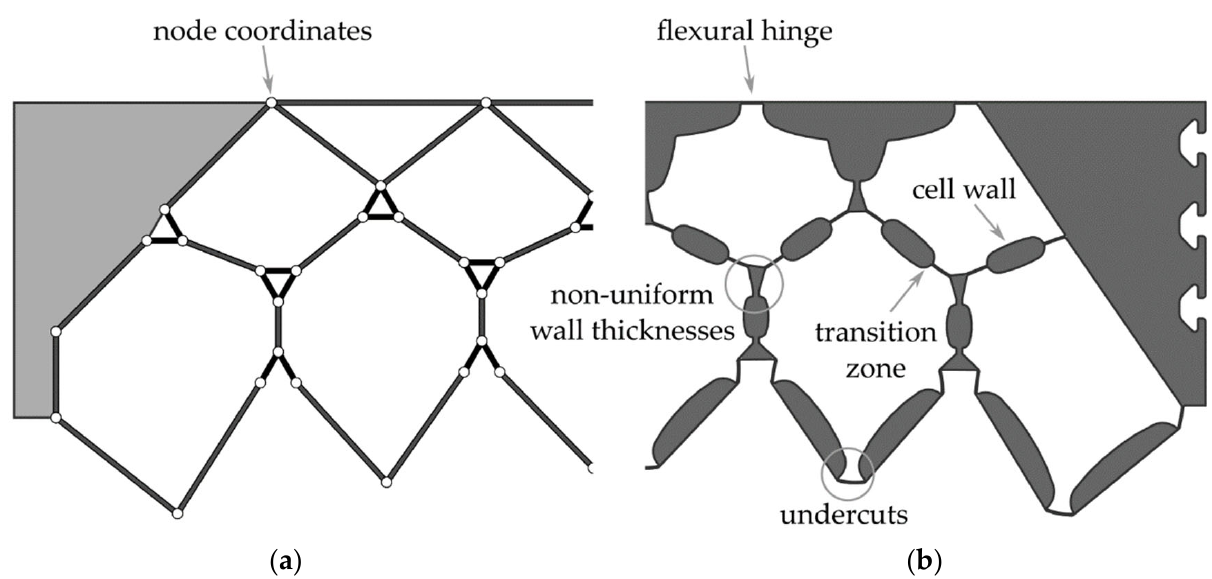
Figure 4. PACS design: ( a ) results from reduced ‐ order truss model; ( b ) cross ‐ sectional design optimized for additive Figure 4. PACSdesign: ( a )resultsfromreduced-ordertrussmodel; ( b )cross-sectionaldesignoptimizedforadditive manufacturing.